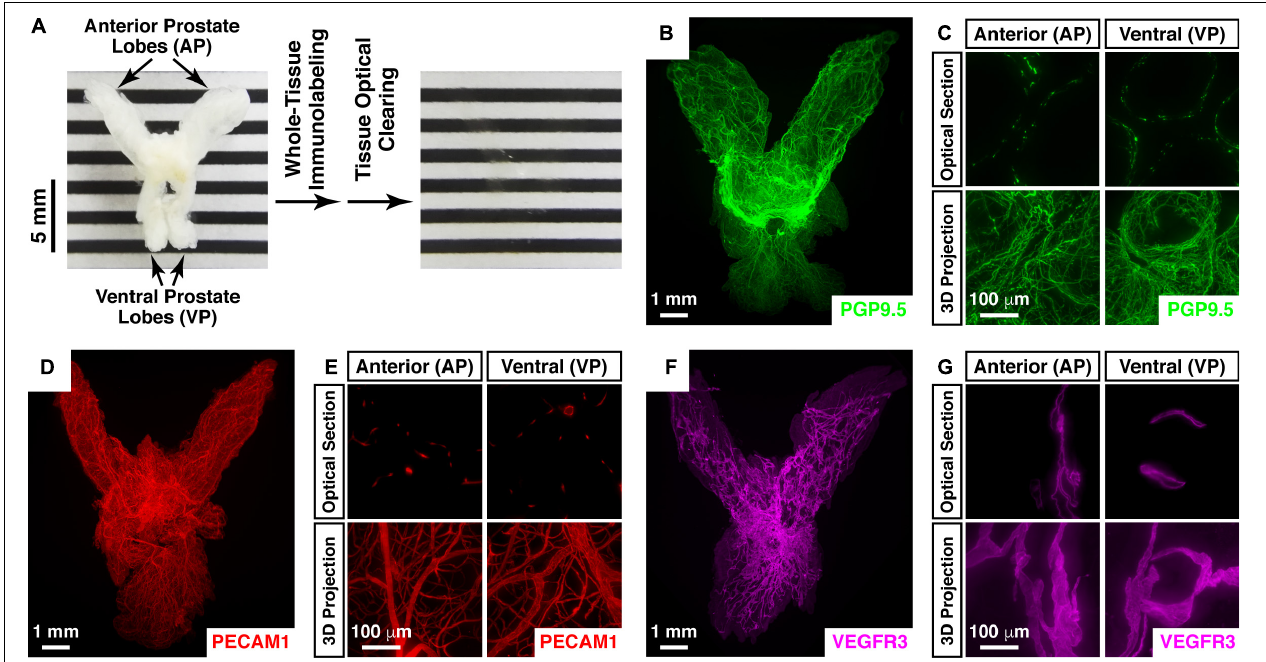
FIGURE 1 | Whole-tissue 3D fluorescence imaging of the mouse prostate. (A–C) 3D fluorescence imaging of neural innervations in the mouse prostate. (A) The intact prostate of the 8-week-old male mouse before (left panel) and after (right panel) the whole-tissue immunolabeling and optical clearing. Anterior prostate (AP) and ventral prostate lobes (VP) are indicated. (B,C) The intact prostate of the 8-week-old male mouse was subjected to the whole-tissue PGP9.5-immunolabeling. (B) Representative 3D projection of the lightsheet imaging is shown. (C) Representative optical sections (upper panels) and 3D projections (lower panels) of the 1-mm thickness of the anterior (AP) and ventral prostate (VP) of the lightsheet imaging are shown. (D,E) 3D assessment of blood vessels in the mouse prostate. The intact prostate of the 8-week-old male mouse was subjected to the whole-tissue PECAM1-immunolabeling. (D) Representative 3D projection of the lightsheet imaging is shown. (E) Representative optical sections (upper panels) and 3D projections (lower panels) of the 1-mm thickness of the anterior (AP) and ventral prostate (VP) of the lightsheet imaging are shown. (F,G) 3D fluorescence imaging of lymphatic vessels in the mouse prostate. The intact prostate of the 8-week-old male mouse was subjected to the whole-tissue VEGFR3-immunolabeling. (F) Representative 3D projection of the lightsheet imaging is shown. (G) Representative optical sections (upper panels) and 3D projections (lower panels) of the 1-mm thickness of the anterior (AP) and ventral prostate (VP) of the lightsheet imaging are